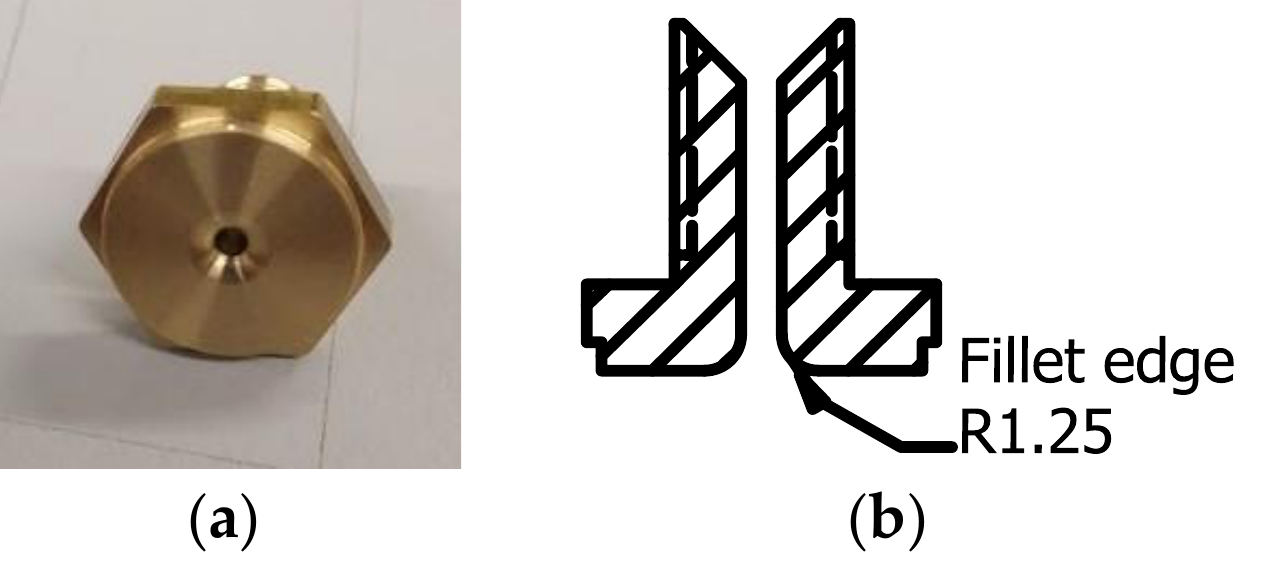
Figure 2. Modified nozzle of 1.4 mm diameter, flat end, and filleted at the outlet: ( a ) the actual nozzle; ( b ) cross section of the side view. Reprinted with permission from [25]. Copyright 2021, Elsevier.